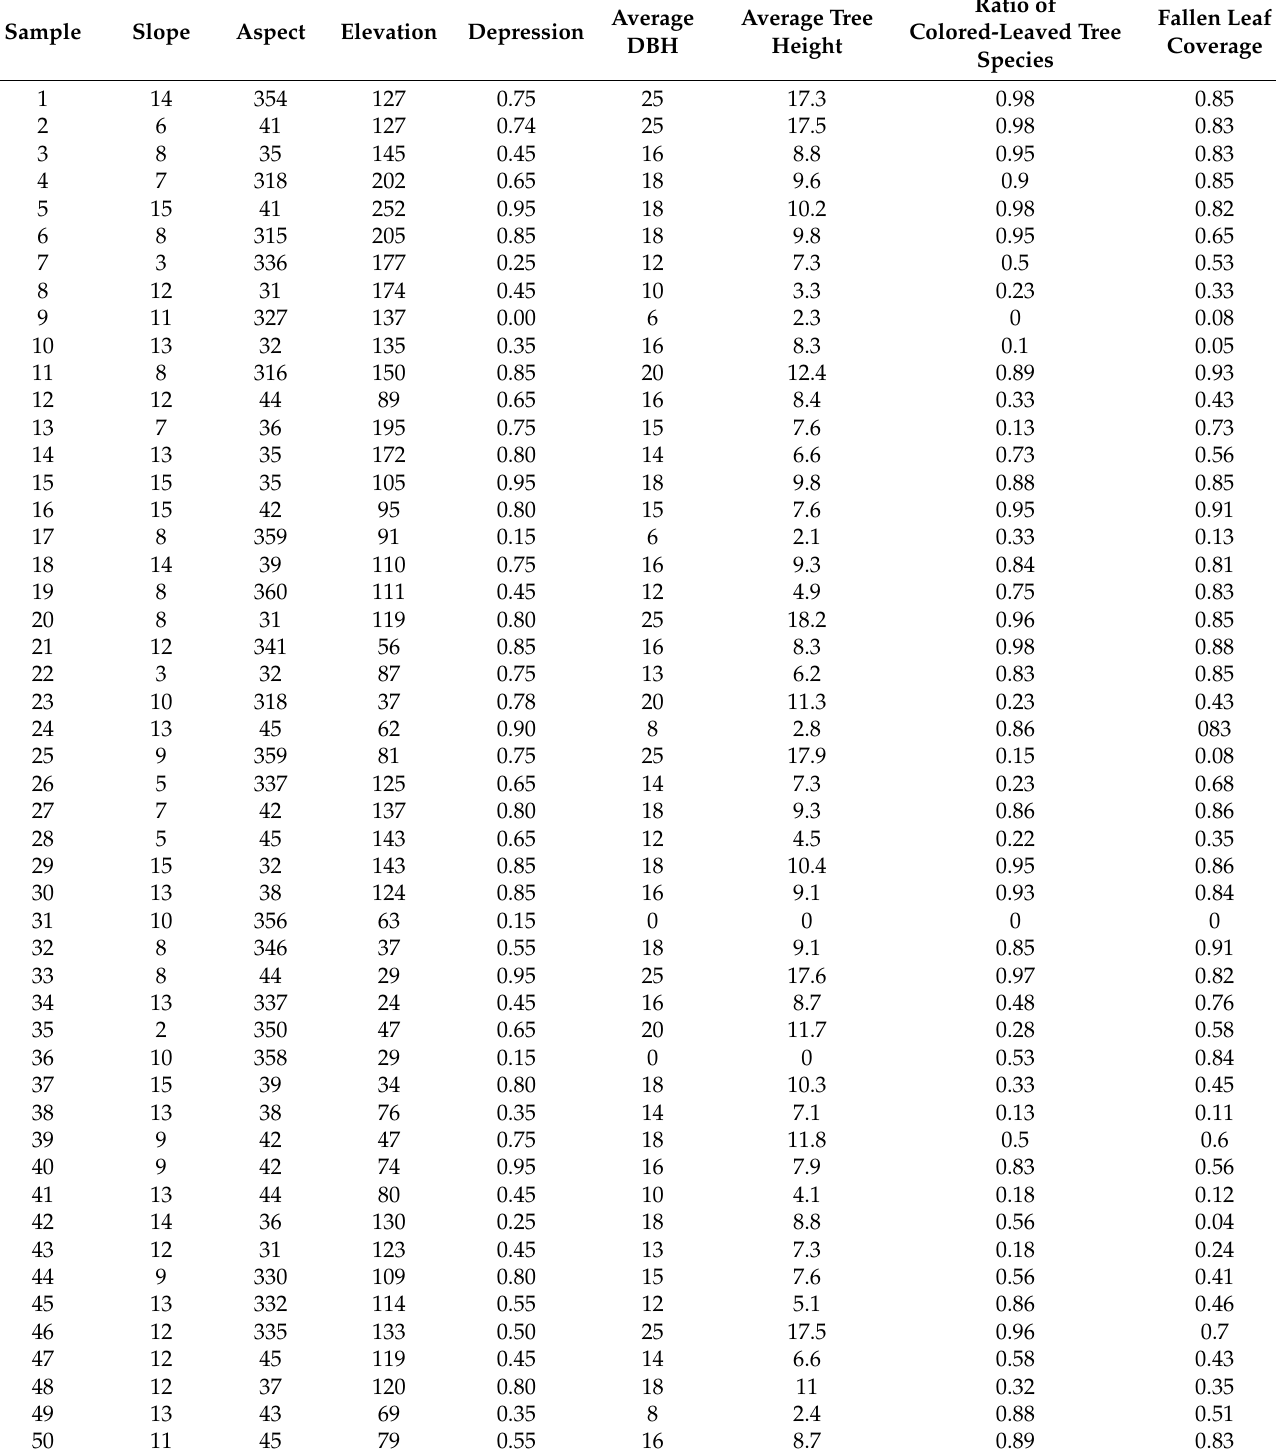
Table 2. Presentation of some information from the sample sire